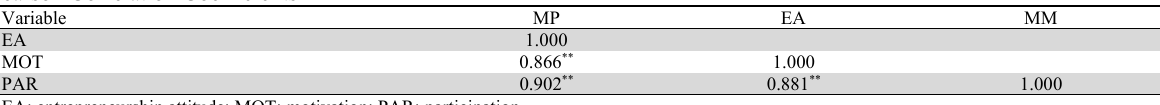
Pearson Correlation Coefficients Variable